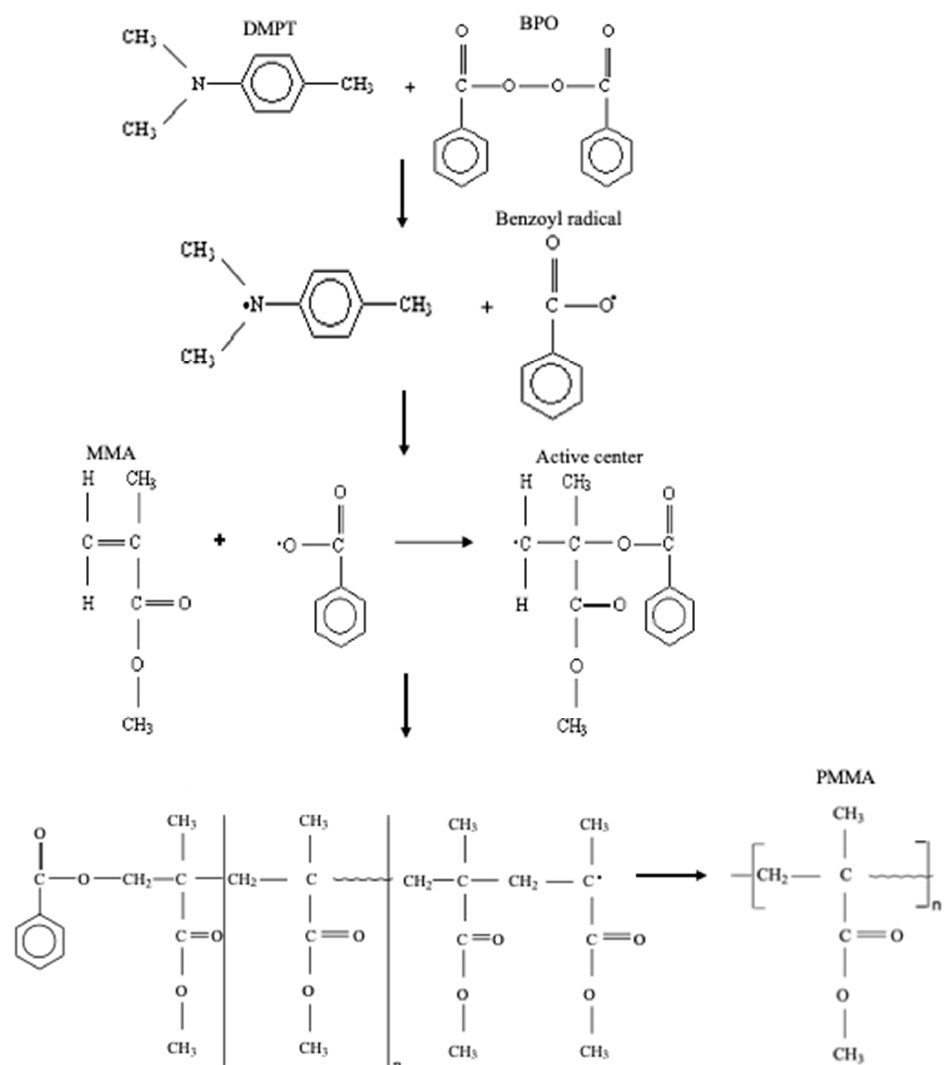
Figure 1. Schematic diagram of the free radical polymerization of MMA.